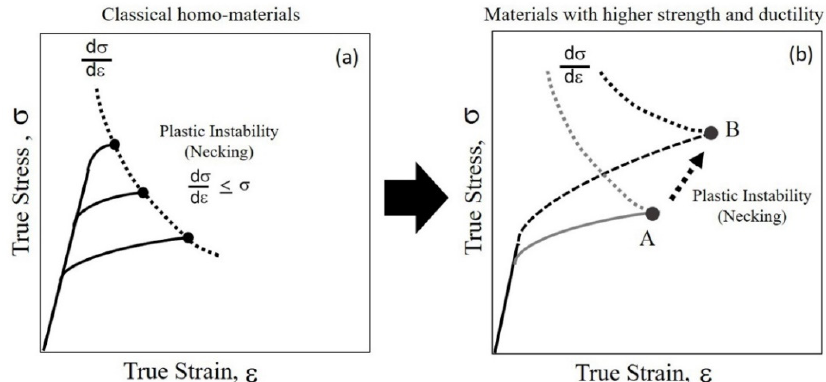
Figure 1. Schematic illustrations of true stress–true strain curves in; ( a ) materials with conventional homogeneous microstructure, and ( b ) advanced materials with a combination of higher strength and ductility.